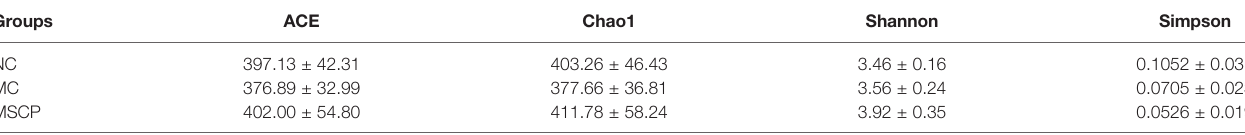
Data are expressed as mean ±